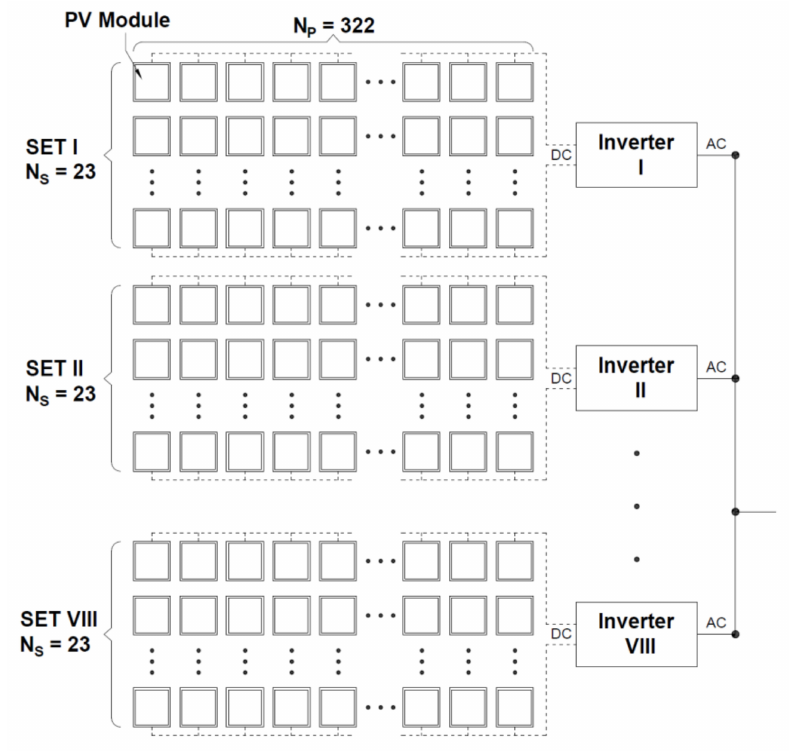
Figure 2. Configuration of photovoltaic